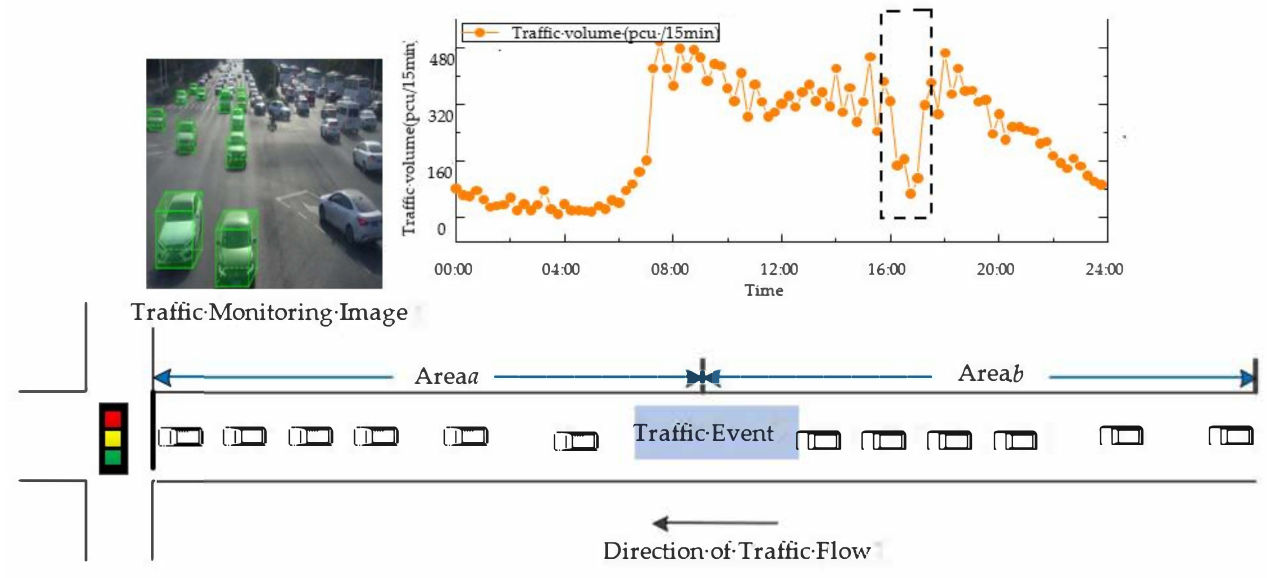
Figure 1. Traffic events cause compression waves and expansion waves; the variation curve of traffic flow parameters under the influence of traffic